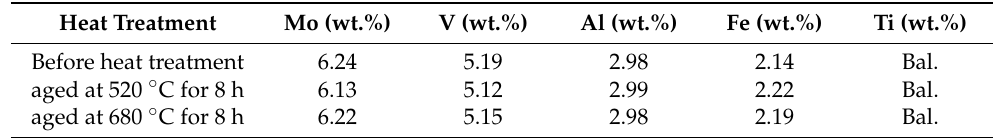
Table 1. Chemical composition of the alloys before and after heat treatments. Heat Treatment Mo (wt.%) V (wt.%) Al (wt.%) Fe (wt.%) Ti (wt.%) Before heat treatment 6.24 aged at 520 ◦ C for 8 h aged at 680 ◦ C for 8